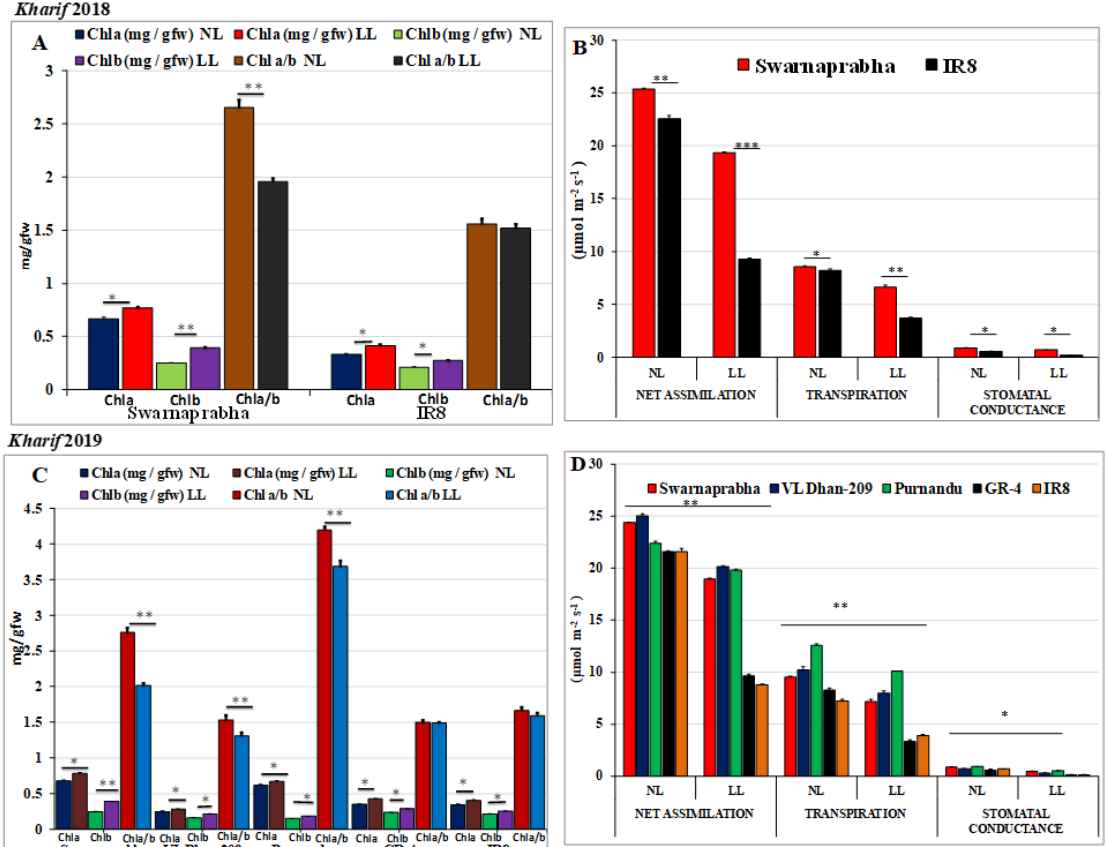
Figure 1. ( A , C ) Chla content, Chlb content, and Chl a/b ratio in different genotypes ( t -test for mean data α = 0.05, 0.01, 0.001). Data were taken after 5 days of low-light-treated samples for both low-light-tolerant and low-light-sensitive rice genotypes in Kharif, 2018, and Kharif, 2019. Y-axis represents Chla, b content (mg/gfw) or Chla/b ratio. ( B , D ) Calculation of photosynthetic parameters in tolerant and sensitive rice genotypes in Kharif seasons of 2018 and 2019: Net assimilation, stomatal conductance, and transpiration measurements were recorded for both open system and treatment with a CO 2 concentration of 380 μmol L − 1 under available light conditions for LL—low light, NL—normal light. An average value was calculated from six flag leaves from each replicate. Note: In Kharif, 2018, only two rice genotypes, Swarnaprabha and IR8, were taken from the same samples which were used for NGS, whereas in Kharif , 2019, three tolerant genotypes—Swarnaprabha, VL